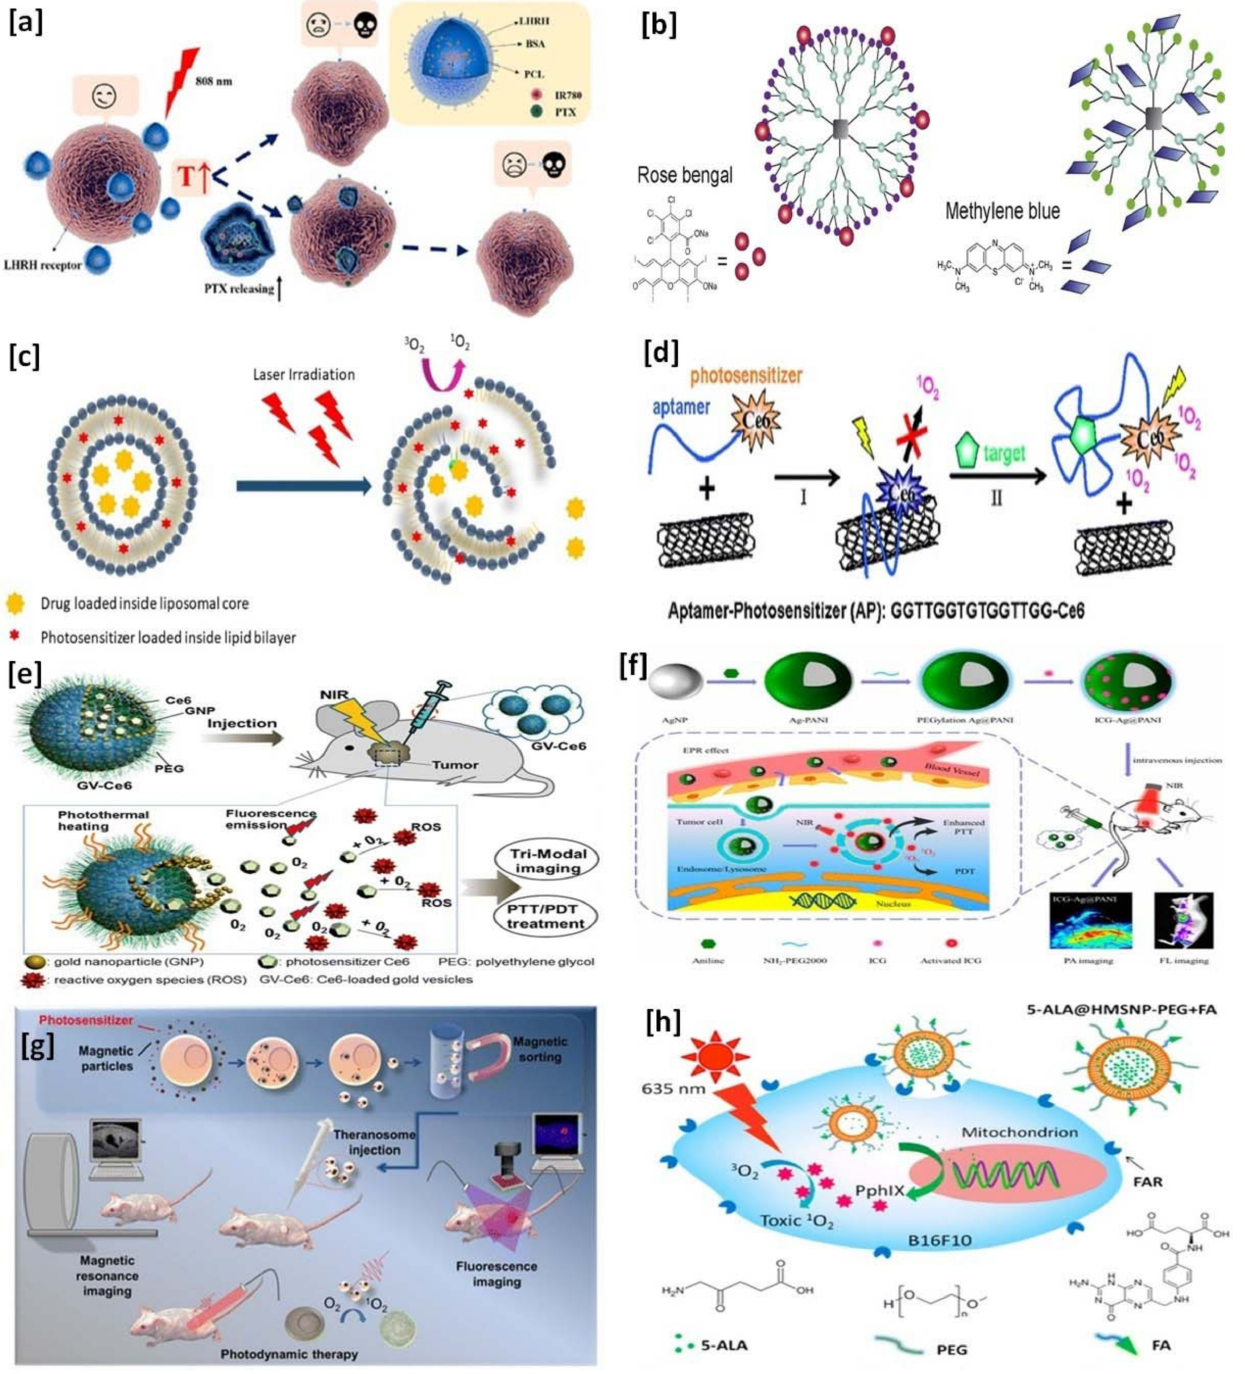
Figure 1. Schematic illustration of photosensitizers-loaded nanocarriers in PDT for the treatment of cancer: ( a )